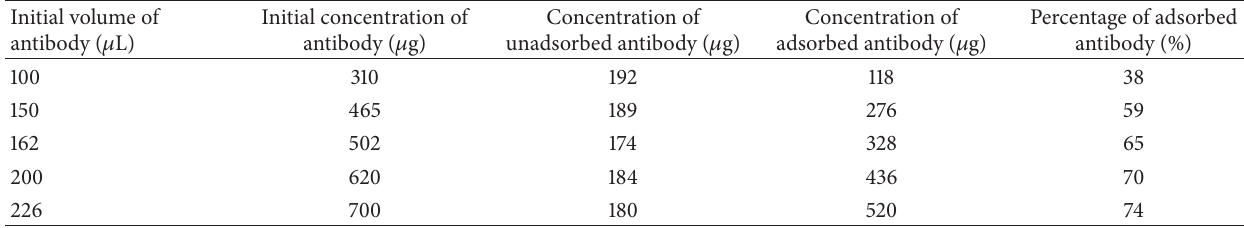
Table 2: Estimated concentration of adsorbed antibody in the VWF antibody-latex